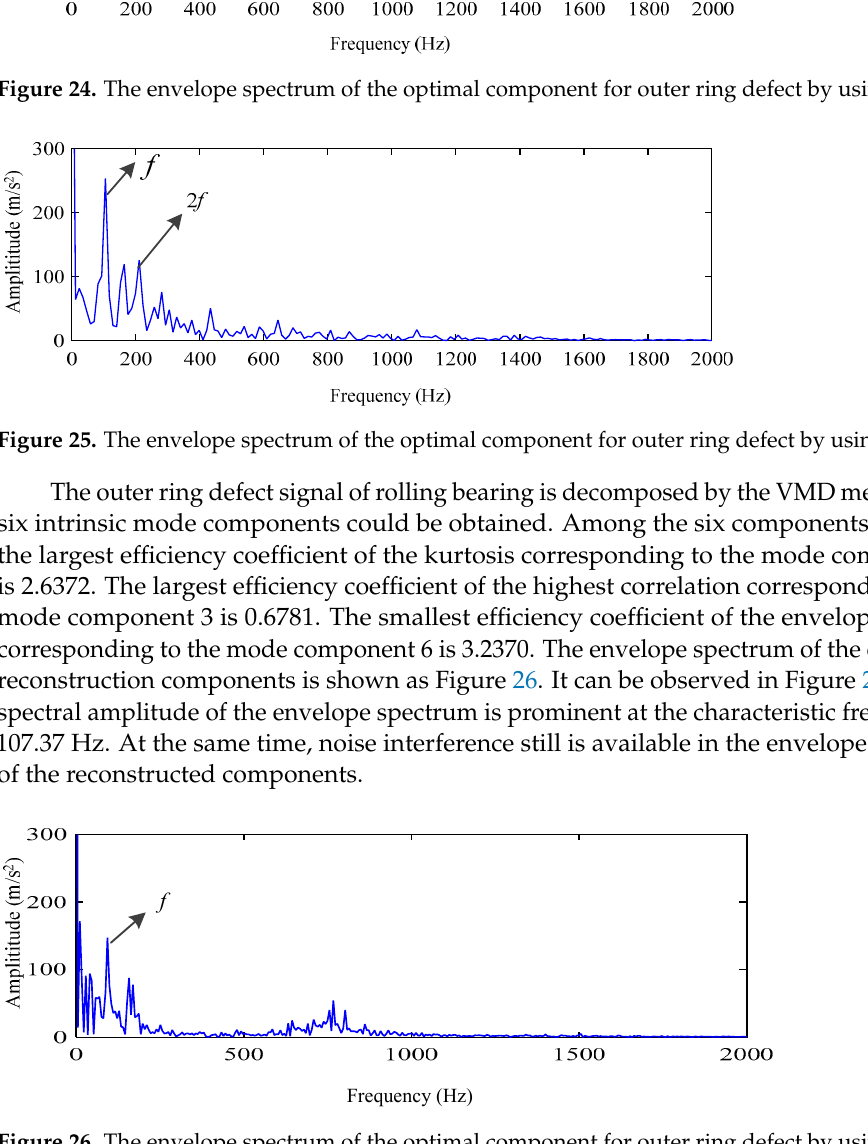
Figure 26. The envelope spectrum of the optimal component for outer ring defect by using VMD.